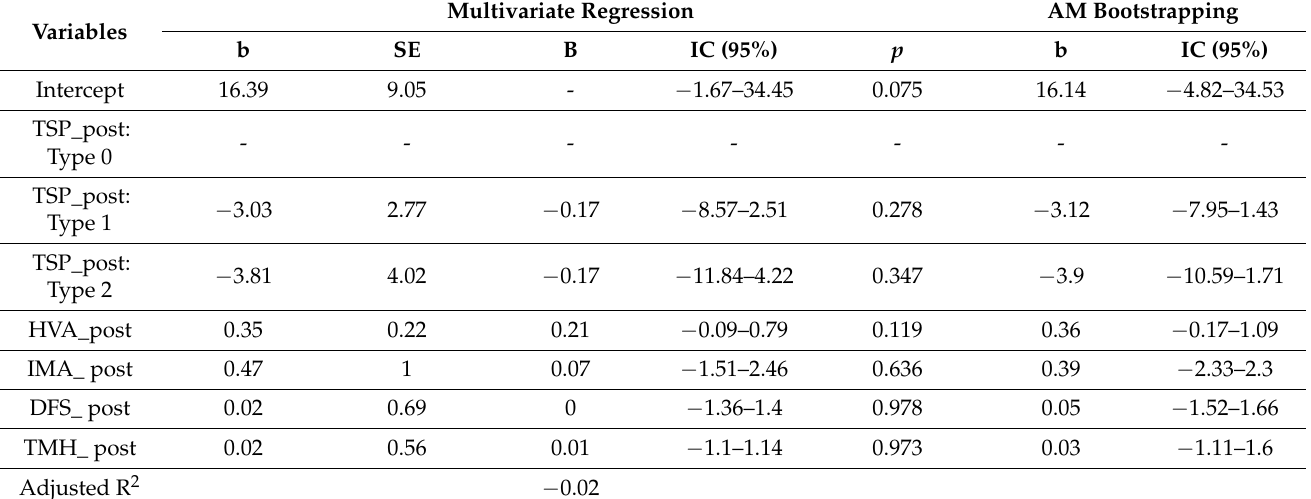
Table 8. Multivariate regression analysis of pre-postoperative MOXFQ values with the pre- postoperative radiological measures. Dif: Differential values. DFS: Distance of the fibular sesamoid bone to the second metatarsal axis. TMH: Translation of the first distal metatarsal head. HVA: Hallux valgus angle. IMA: I–II intermetatarsal angle. TSP : Tibial Sesamoid Position. MOXFQ: